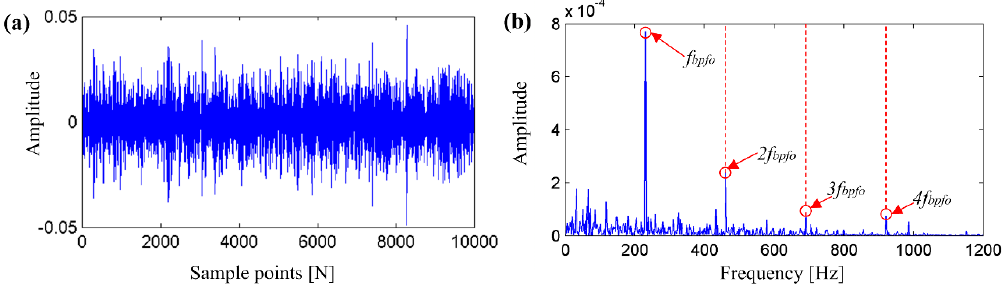
Figure 23. ( a )The extracted fault feature signal of of group 533; ( b ) The teager energy operator spectrum of group 533.